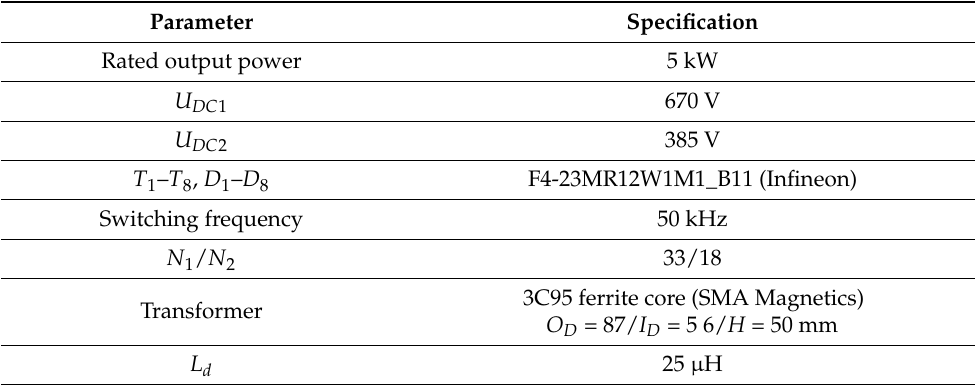
Table 2. The DAB converter specifications.